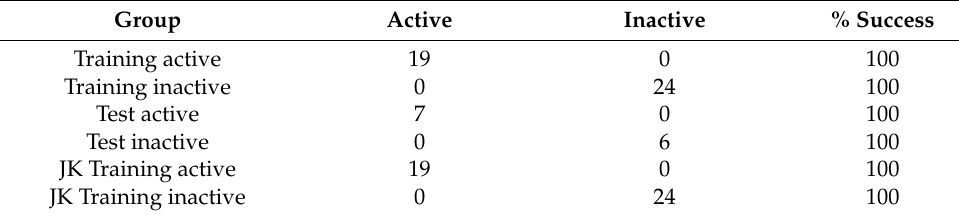
Table 3. Classification matrix for DF MRSA3 . Group